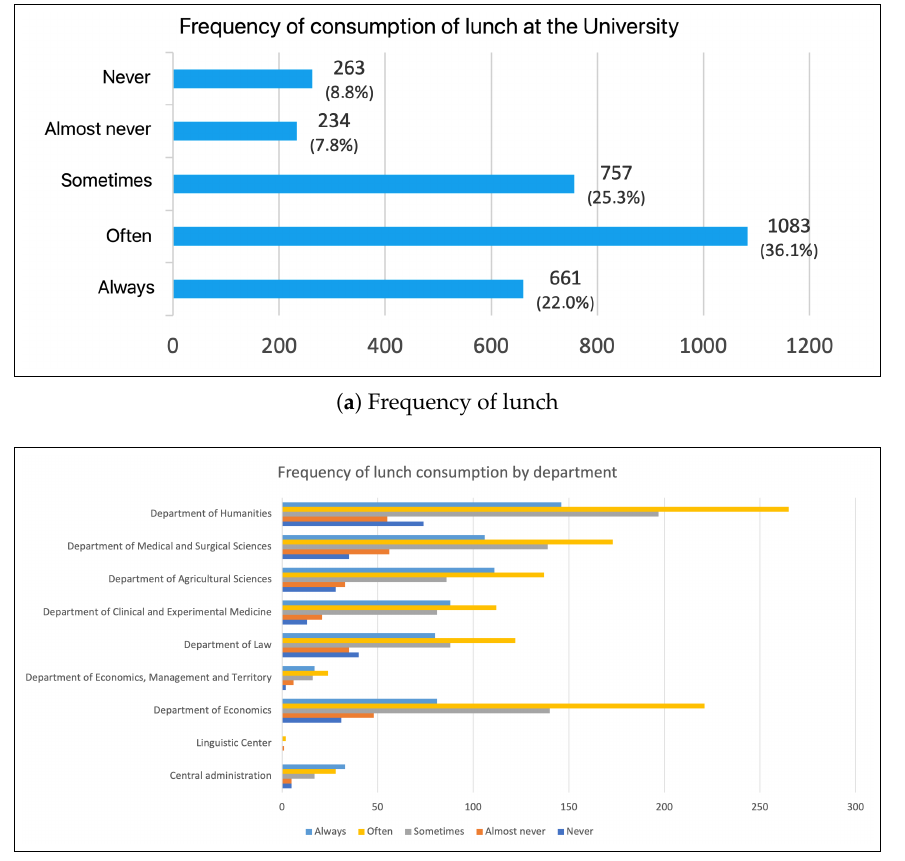
Figure 24. Frequency of lunch at